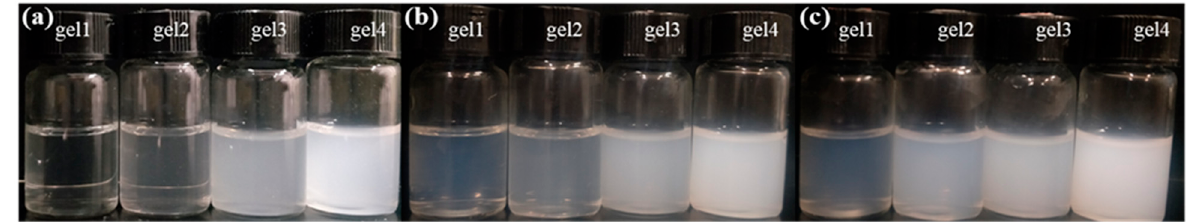
Figure 5. Digital photo of temperature sensitivity of gel 1–4 (2 mg/mL) ( a ) 25 °C, ( b ) 35 °C, ( c ) 45 °C.